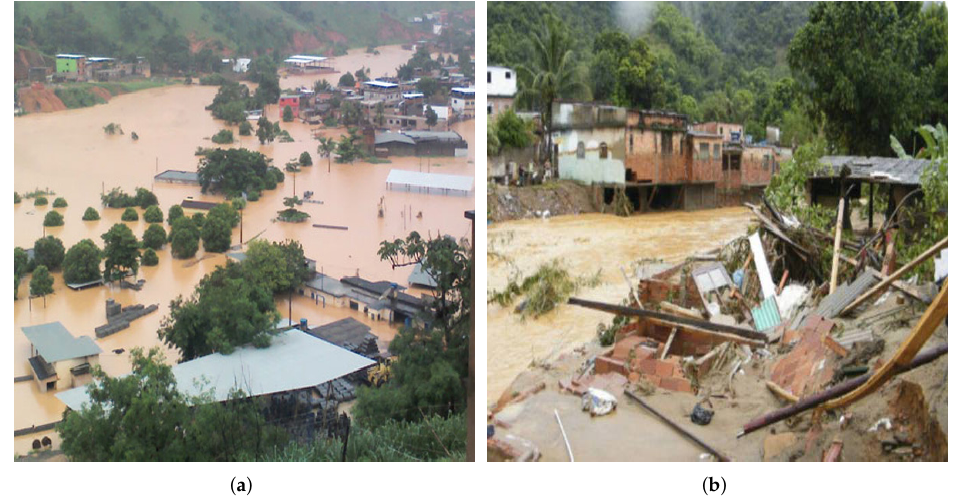
Figure 7. Municipalities affected by the extreme rain. ( a ) flooding in municipality of Muriaé on Minas Gerais state; ( b ) collapse of houses in municipality of Duque de Caxias on Rio de Janeiro state.